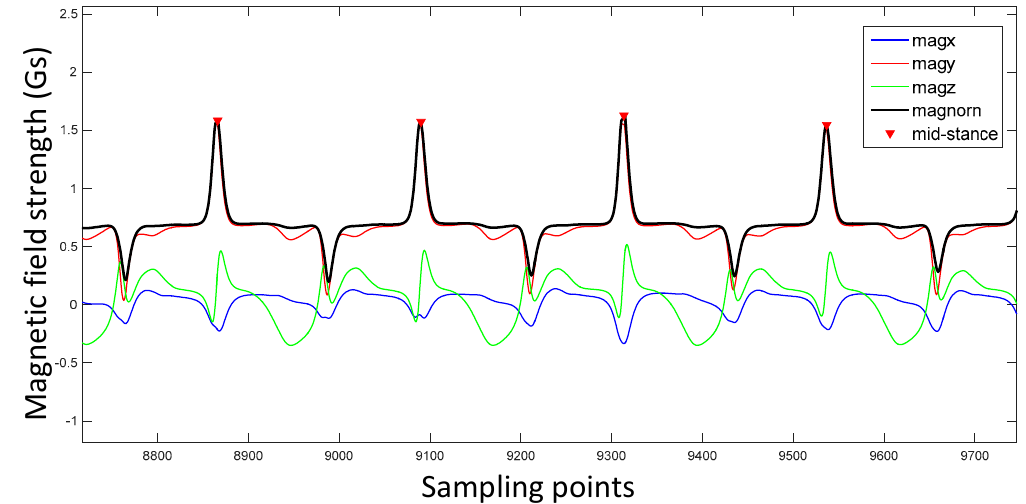
Figure 10. Comparison of different magnetic field strength waveforms. The blue line, red line, green line and black line are magx , magy , magz and magnorm , respectively. Mid-stances (peaks) from magnorm are marked with red triangles.